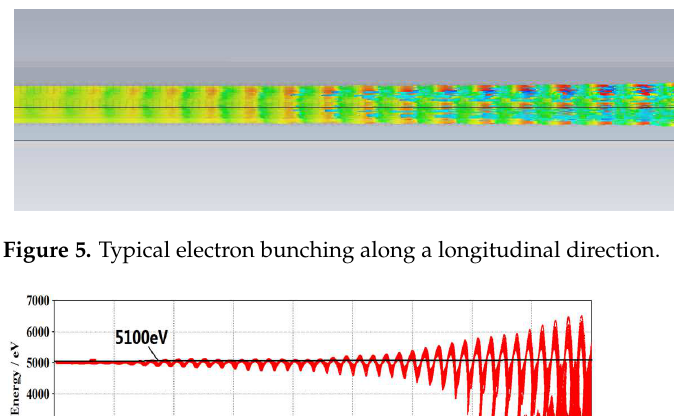
Figure 5. Typical electron bunching along a longitudinal direction.